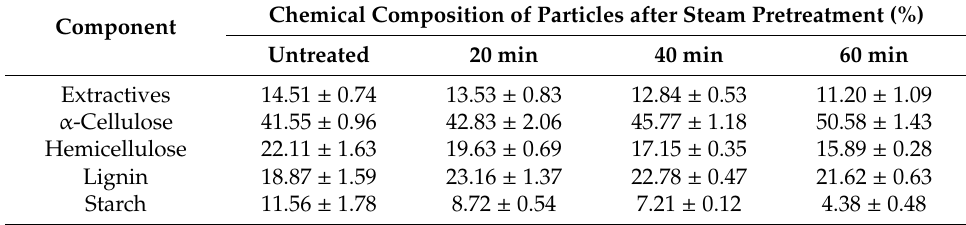
Table 1. Chemical composition of oil palm trunk particles after steam pretreatment.